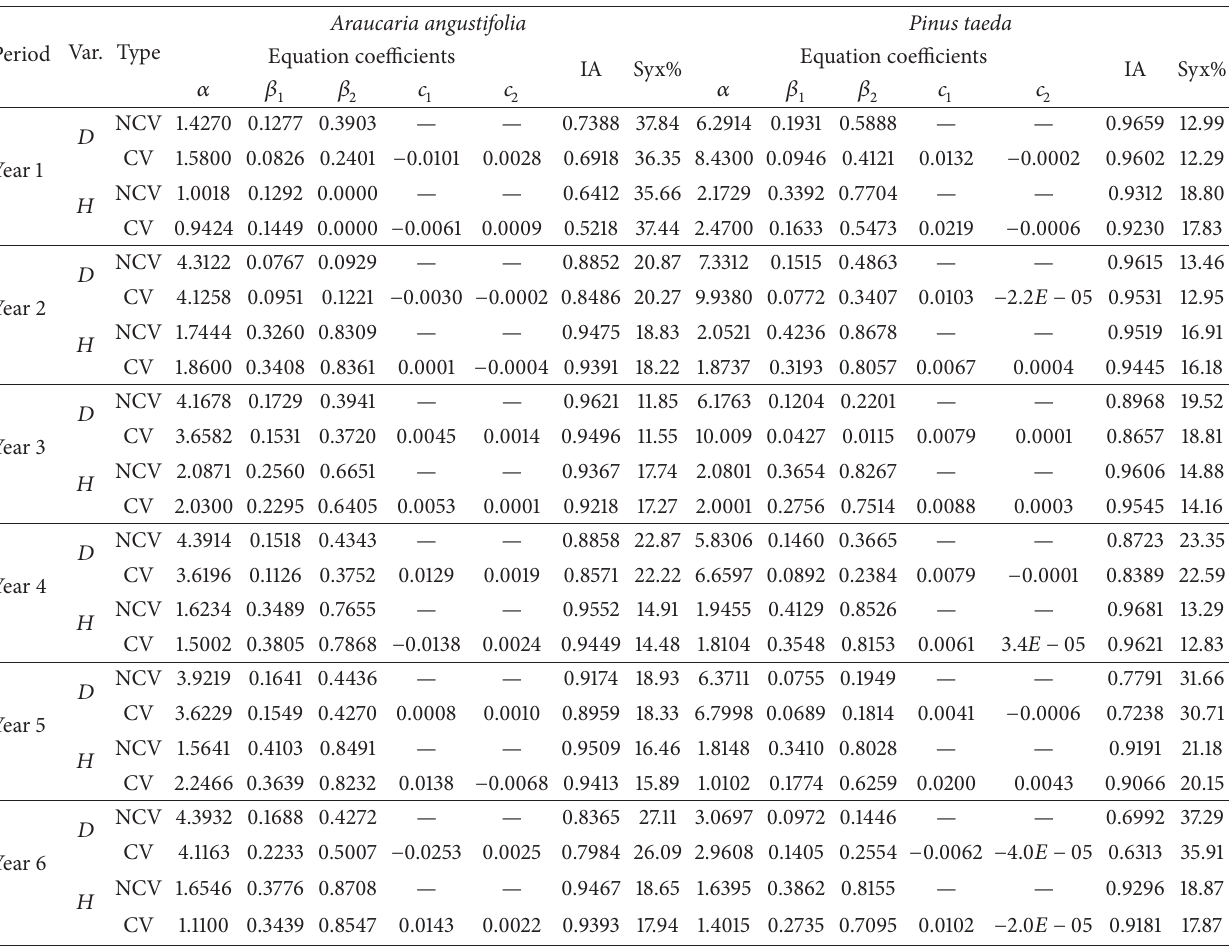
Table 4: Coefficients and statistics of the Chapman-Richards equation for monthly production in diameter ( 𝐷 ) and height ( 𝐻 ) of Araucaria angustifolia and Pinus taeda, with (CV) and without (NCV) the inclusion of climate variables. Araucaria Period Var. Type